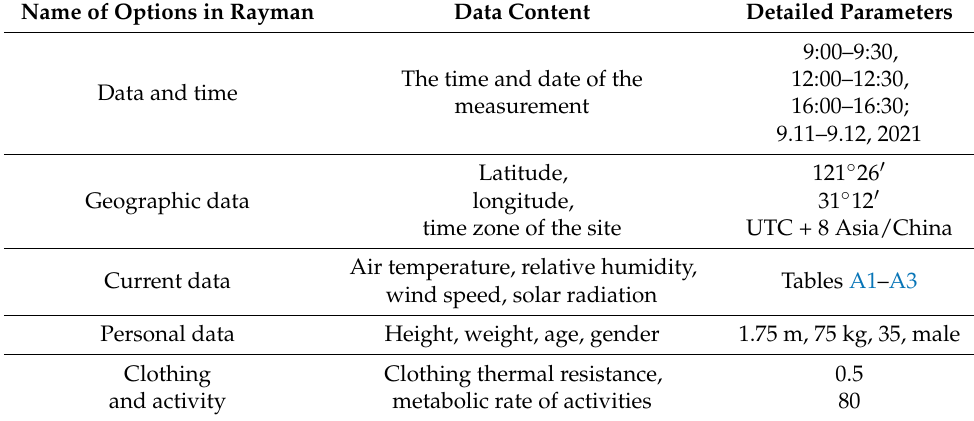
Table A4. Data required for